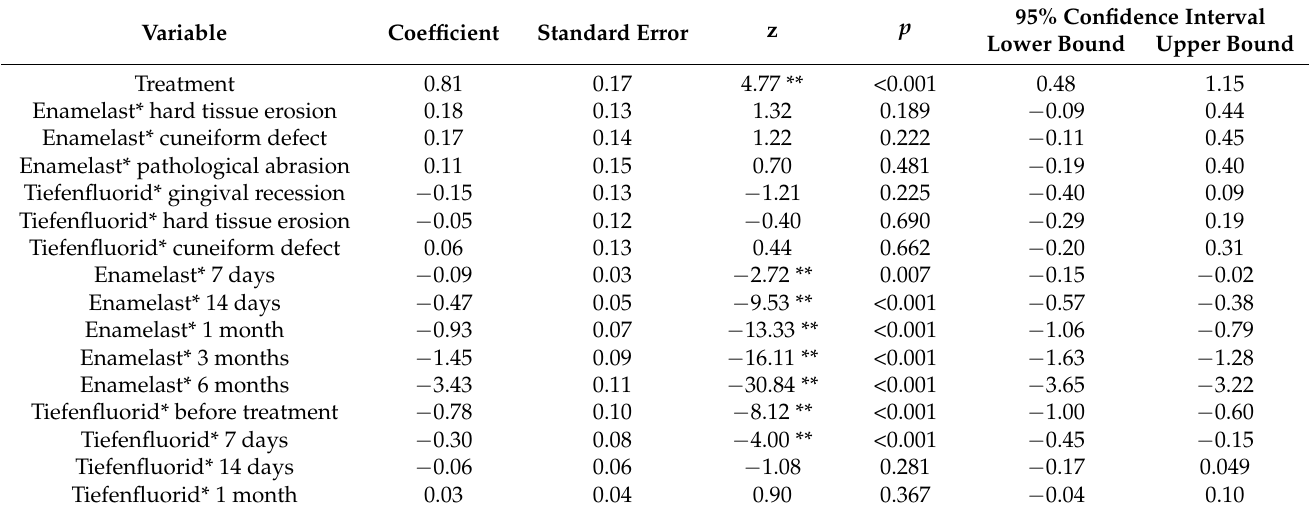
Table 3. Random intercept/random slope model of the effect of treatment, time, and defect diagnosis on the measured dentinal sensibility.